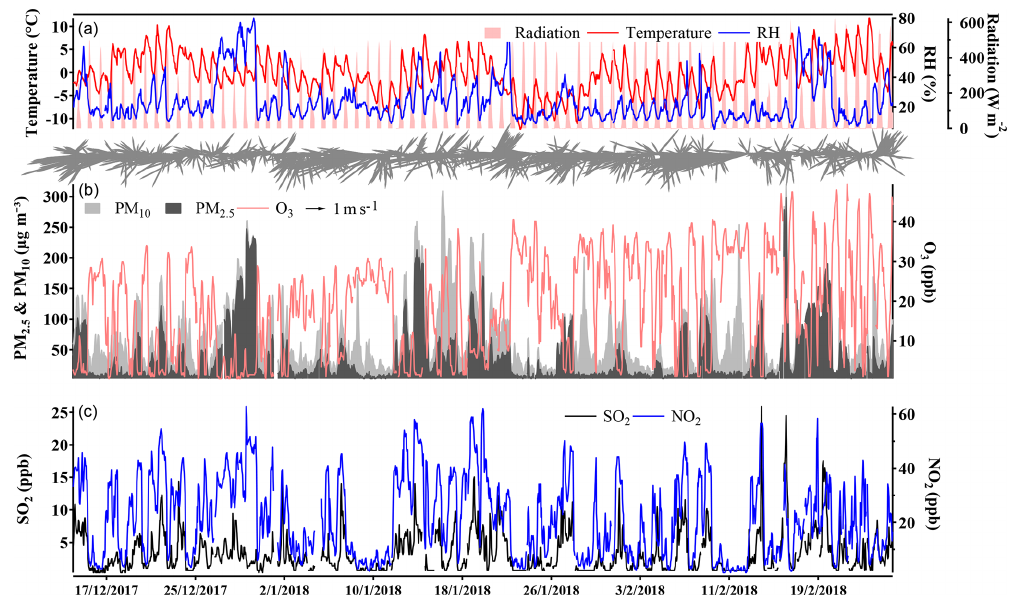
Figure 1. Time series of major pollutants during the campaign. (a) Radiation, temperature RH, and wind arrows (drawn below); (b) PM 2 . 5 , PM 10 , and ozone concentration; (c) SO 2 and NO 2